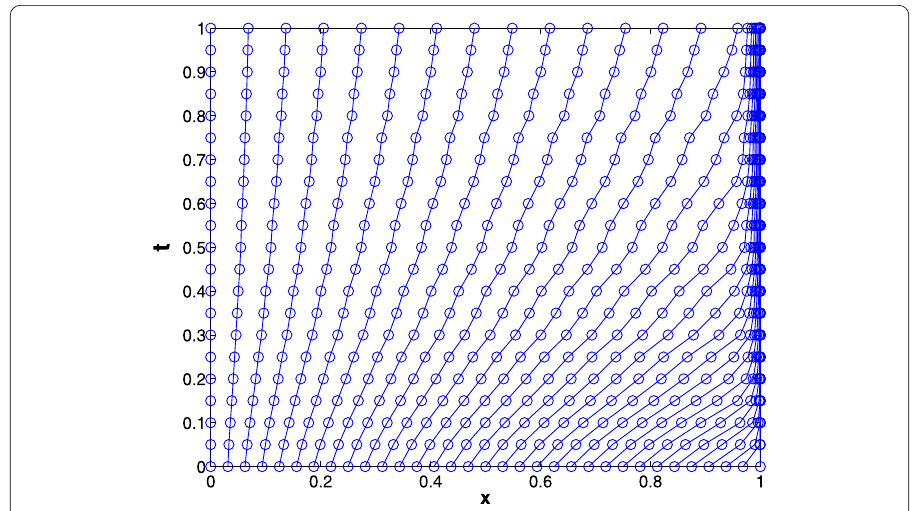
Figure 1 Grid movement of the algorithm for Example 5.1 with N = 32, M = 20, ε 1 = 10 –2 , and ε 2 = 10 –4